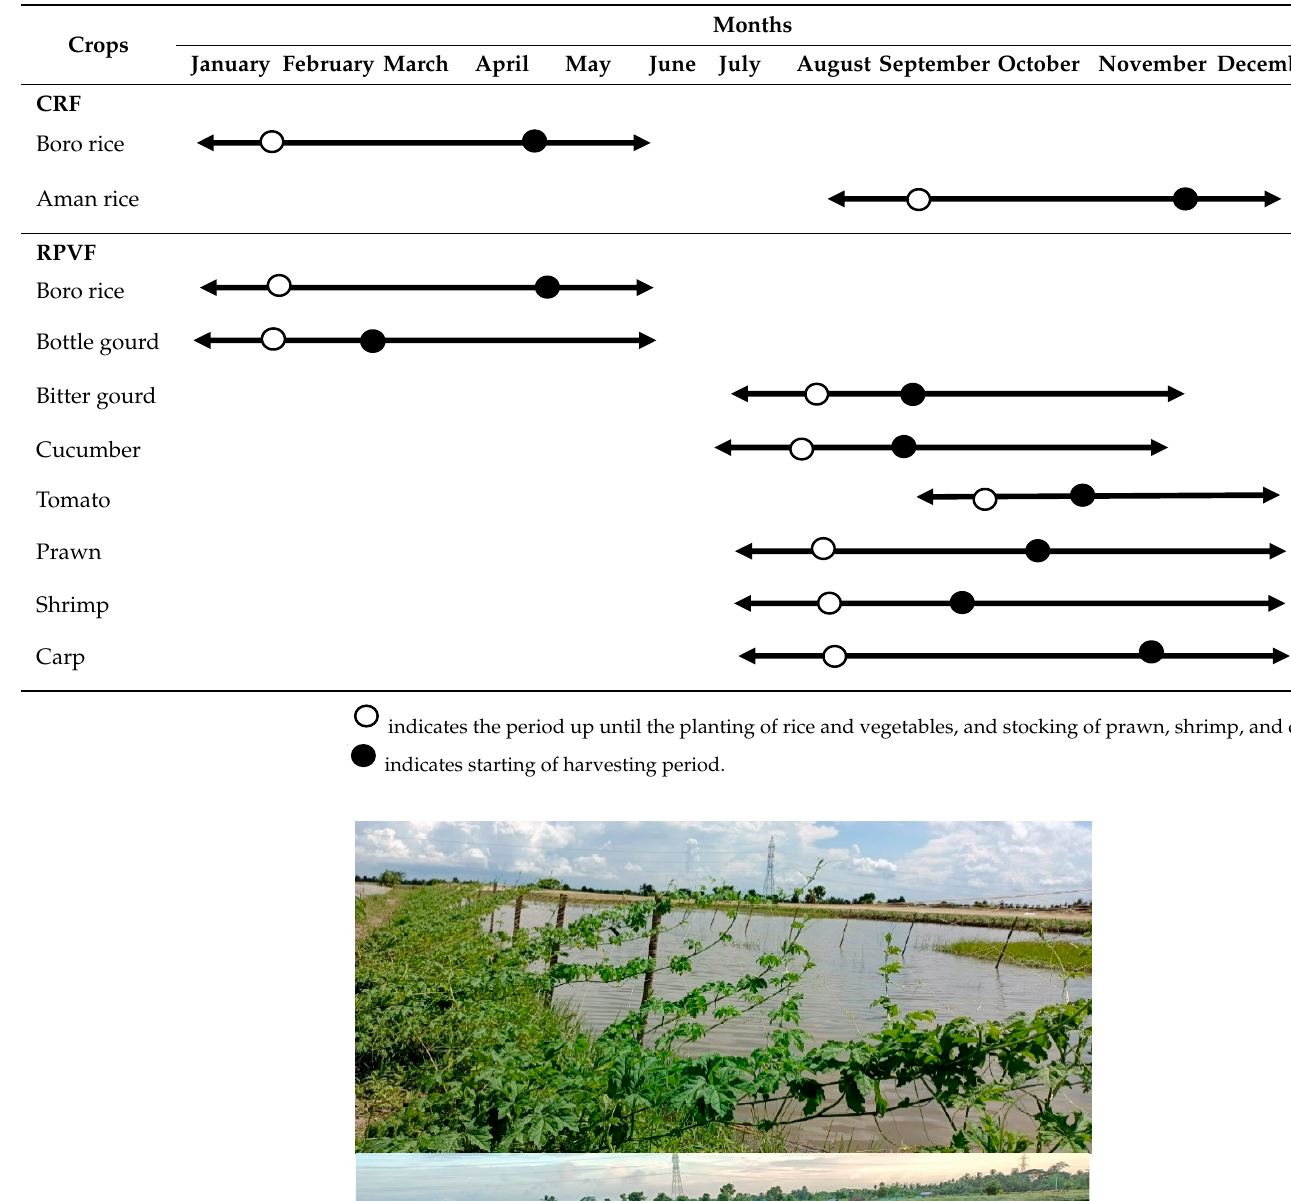
Table 3. Cropping patterns and seasonality for conventional rice farms (CRF) and rice–prawn–vegetable farms (RPVF).